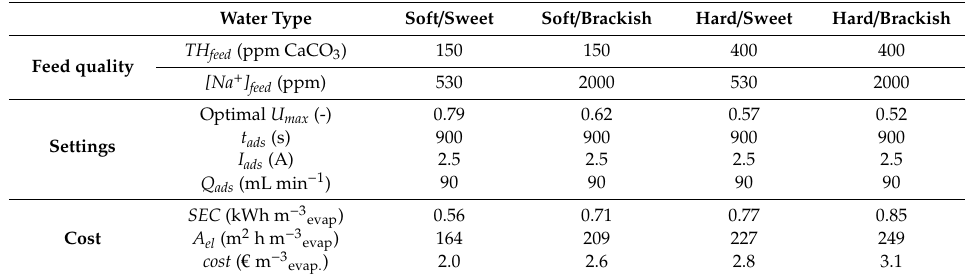
Table 4. Optimal U max for membrane capacitive deionization cooling towers (MCDI-CT) system (from screening tests) and corresponding operational conditions ( t ads , I ads , Q ads ), specific energy consumption